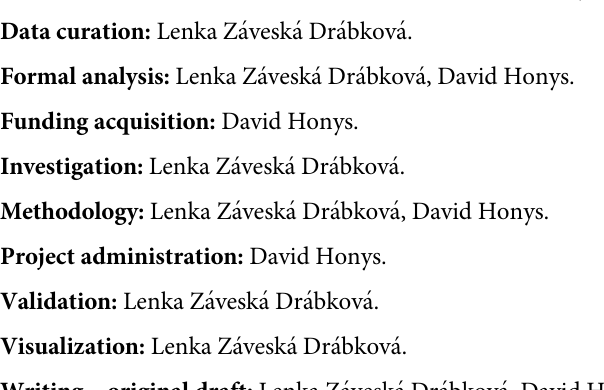
S6 Fig. Phylogenetic tree of pollen-expressed CalS 12 (GLS5) proteins rooted with Physco- mitrella patens . The timetree shown was generated using RelTime. The estimated log likeli- hood value of the topology shown is -79253.3574. A discrete gamma distribution was used to model the differences in evolutionary rate amongst sites (five categories (+ G , parameter = 0.6942)). The model of rate variation allowed some sites to be evolutionarily invariable ([+ I ], 13.5059% sites). The tree is drawn to scale, with branch lengths measured in relative number of substitutions per site. The analysis included 139 amino acid sequences, and the final data set had a total of 2299